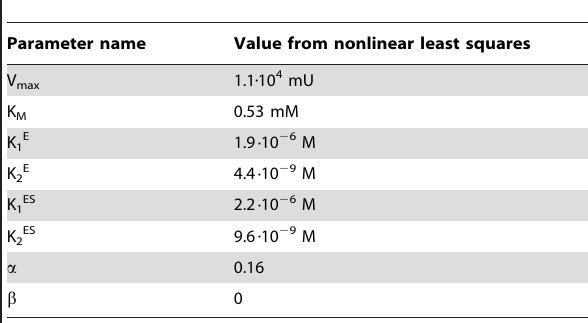
Table 2. Parameters of the diprotic model of enzymatic activity as determined by nonlinear least squares